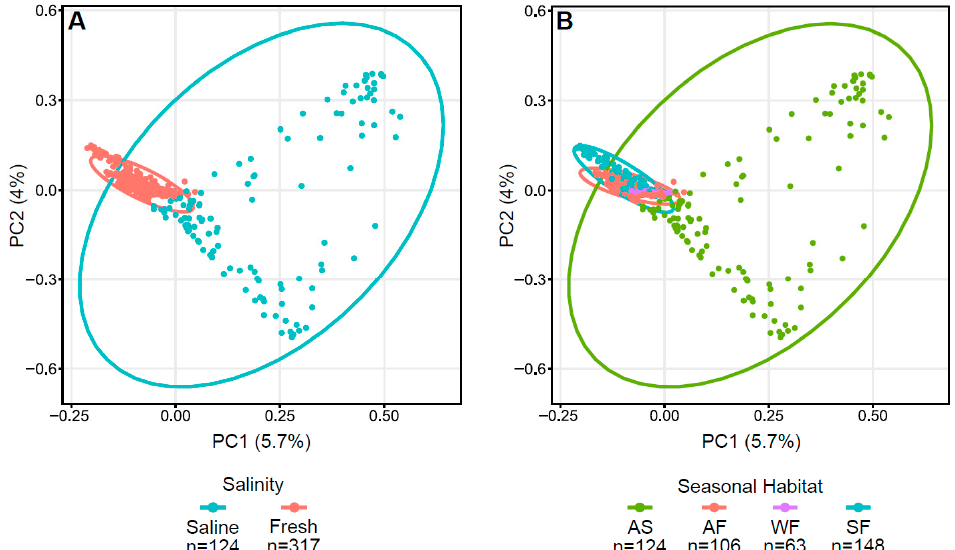
Figure 3. Principal coordinate analysis (PCoA) plots displaying dissimilarities in Arctic char skin samples using Bray–Curtis or beta diversity calculations. PCoA plots with ( A ) saline and freshwater environments and ( B ) seasonal habitats of autumn saline water (AS), autumn fresh water (AF), winter fresh water (WF), spring fresh water (SF). Number of fish samples per group (n) are indicated below the graphs.